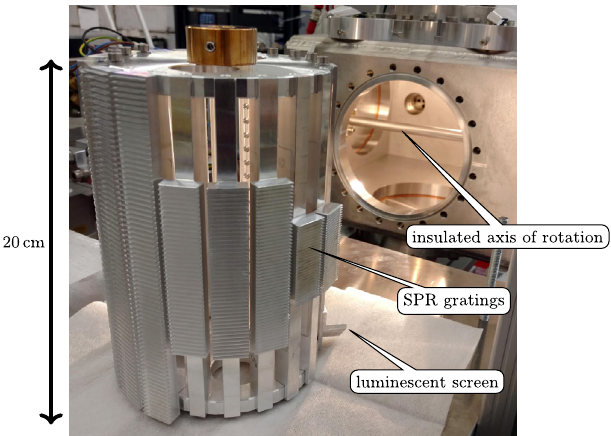
FIG. 6. Drum on which up to 20 gratings can be mounted ( 0 . 75 mm < D < 6 mm). Transverse diagnostic tools (screens, holes, and wires) are contained as well. When installed in the SPR chamber, the drum is mounted on an insulated, rotatable axis.